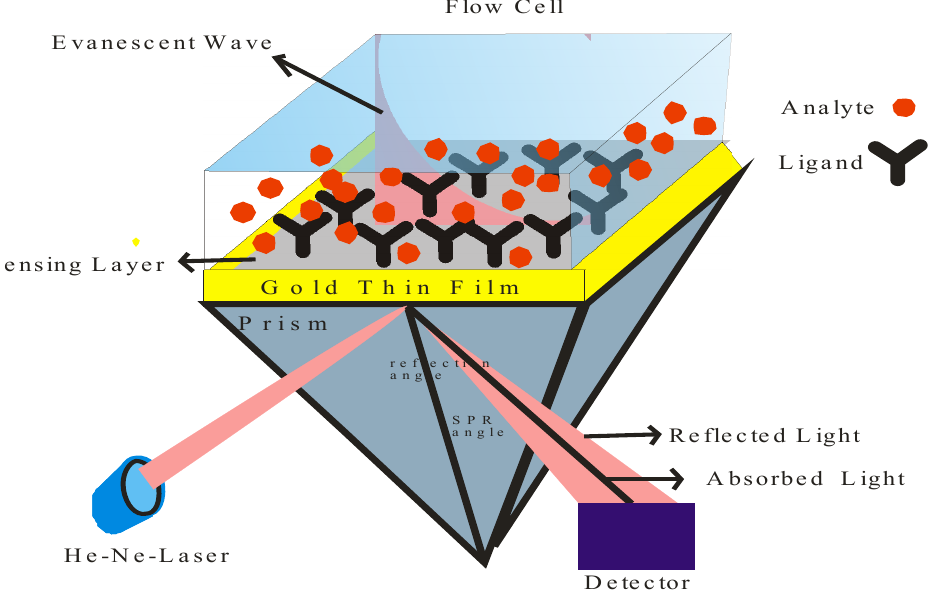
Figure 16. Schematic illustration of SPR setup.